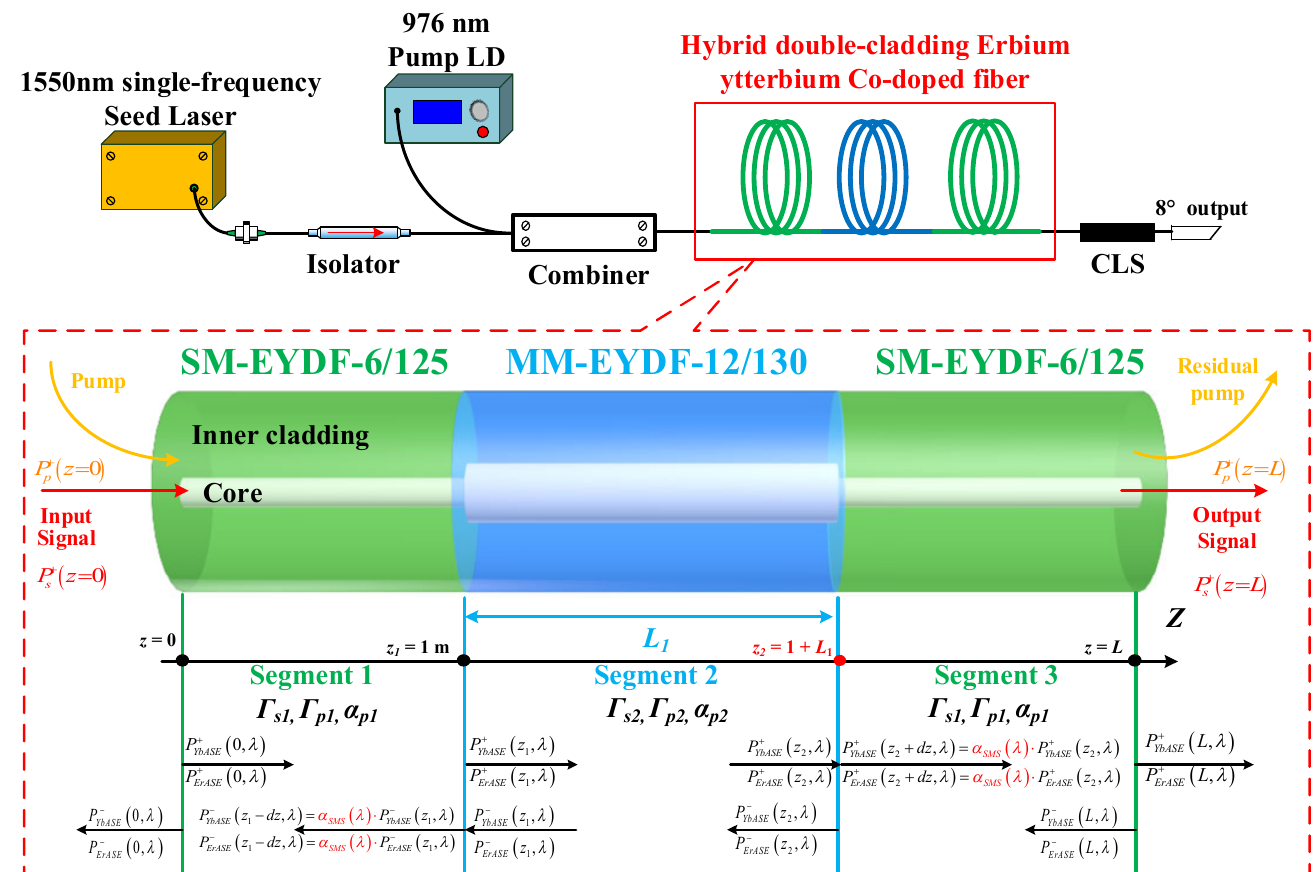
Figure 1. The schematic diagram of the hybrid EYDF amplifier. CLS, cladding light striper.